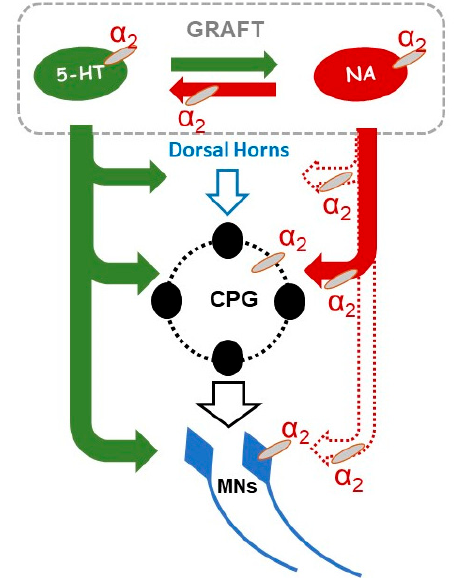
Figure 11. Schematic diagram with graphic indications of postulated serotonergic / noradrenergic (5-HT / NA) direct and indirect actions in the control of hindlimb locomotor performance in paraplegic rats with intraspinal grafting of the embryonic brainstem tissue. The 5-HT and NA axonal connections with dorsal horns and CPG structures and MNs in the ventral horns as well as a reciprocal interaction between 5-HT <=> NA indicate possible direct and indirect mechanisms involved in hindlimb locomotor performance: 1 / action via 5-HT descending system on the spinal cord CPG / MNs (green arrows); 2 / action via NA descending system on the spinal cord CPG / MNs (red arrows); 3 / action based on reciprocal connections of NA vs. 5-HT neurons within the graft (square NA <=> 5-HT) that controls the 5-HT and NA release (for more details see the Discussion). The red field arrow indicates NA connection established in this study while the red dashed lines indicate NA connections in control condition, not re-established by the intraspinal grafting in the present paper. Abbreviations: NA—tyrosine hydroxylase positive neurons in the graft; 5-HT—tryptophan hydroxylase / serotonin positive cells in the graft; MNs—motoneurons; CPG—central pattern generator; α 2 — α 2 adrenergic receptors.